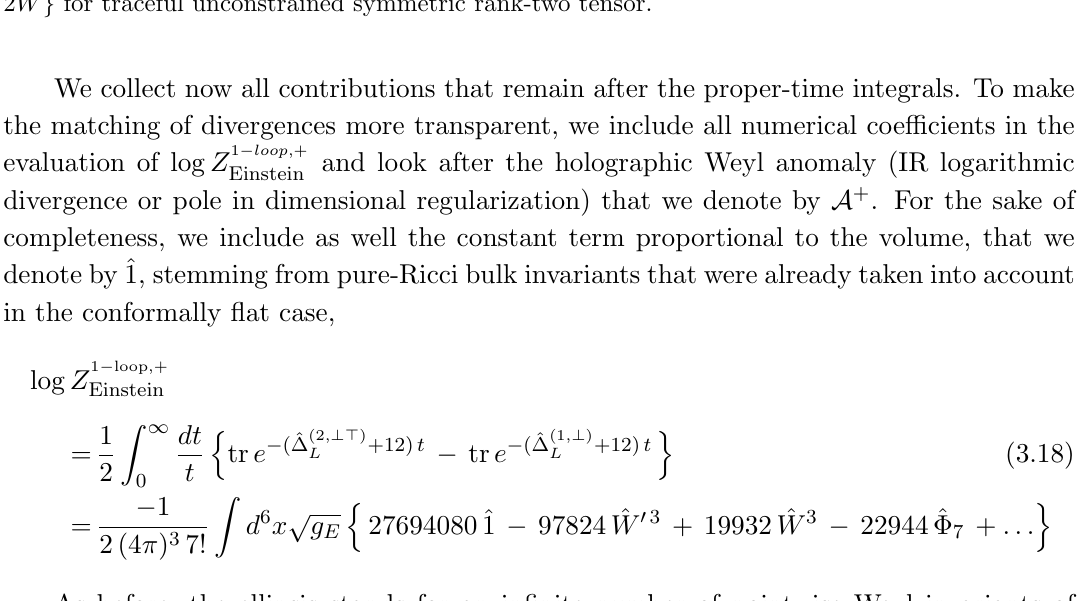
Table 3 . Weyl content of curvature and endomorphism contributions to heat coefficient 2 ˆ W } for traceful unconstrained symmetric rank-two